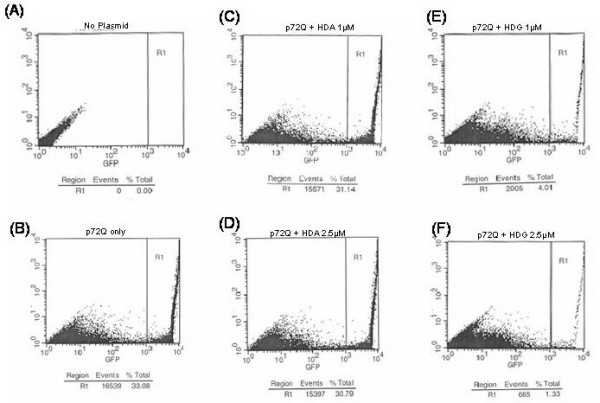
Inhibition of mutant Htt fragment aggregation by oligonucleotides as measured by FACS. HEK293 cells were transfected with pcDNA3.1-72Httexon1-eGFP (p72Q) and the specific ODN (HDA, HDG) at the indicated concentrations and the degree of aggregation measured by FACS after 48 hours. (A) No plasmid (p72Q); (B) only p72Q, no ODN; (C) p72Q and 1 μM HDA; (D) p72Q and 2.5 μM HDA; (E) p72Q and 1 μM HDG; (F) p72Q and 2.5 μMHDG. All ODNs are at final concentrations in the cell culture reaction. The magnitude of green fluorescence is measured on the X axis while the number of cells exhibiting that degree of fluorescence is depicted on the Y axis.